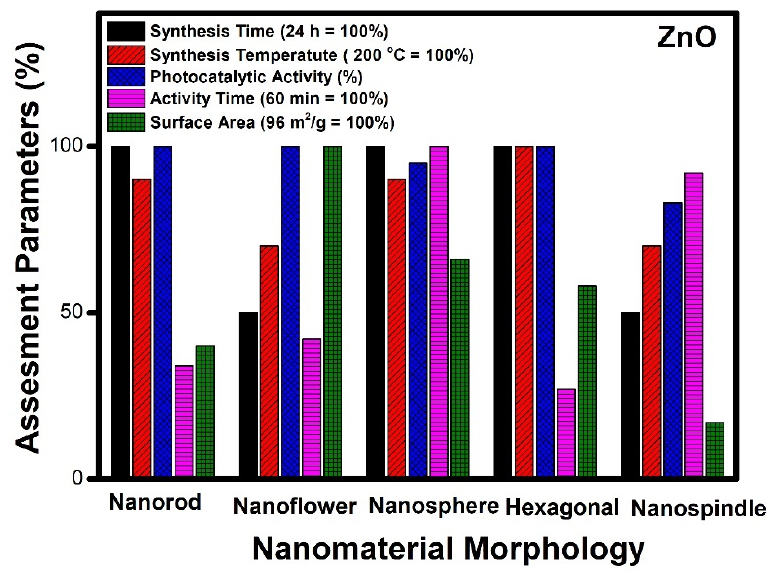
Figure 4. Assessment of different morphologies of ZnO based on various parameters.